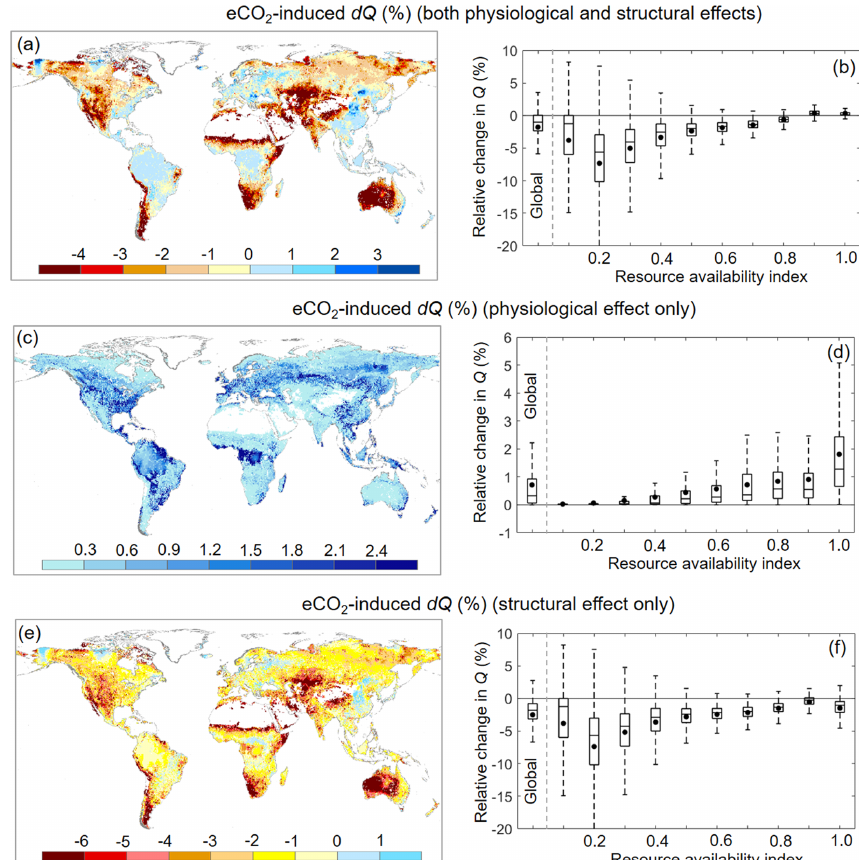
Figure 6. Relative Q change induced by eCO 2 during 1982–2010 across the global vegetated lands. (a) Spatial distribution of relative change in Q induced by eCO 2 . (b) Boxplot of relative change in Q induced by eCO 2 for each resource availability index category. (c) Spatial distribution of relative change in Q induced by eCO 2 when only the physiological effect is considered. (d) Boxplot of relative change in Q induced by eCO 2 when only the physiological effect is considered for each resource availability index category. (e) Spatial distribution of relative change in Q induced by eCO 2 when only the aboveground and belowground structural effects are considered. (f) Boxplot of relative change in Q induced by eCO 2 when only the aboveground and belowground structural effects are considered for each resource availability index category. In (b) , (d) , and (f) the upper and lower box edges represent the quartile divisions, the inner horizontal line is the median, the dots indicate the mean, and the dashed lines represent the 5th and 95th percentiles. The number of grid cells in each resource availability index category is provided in Fig.